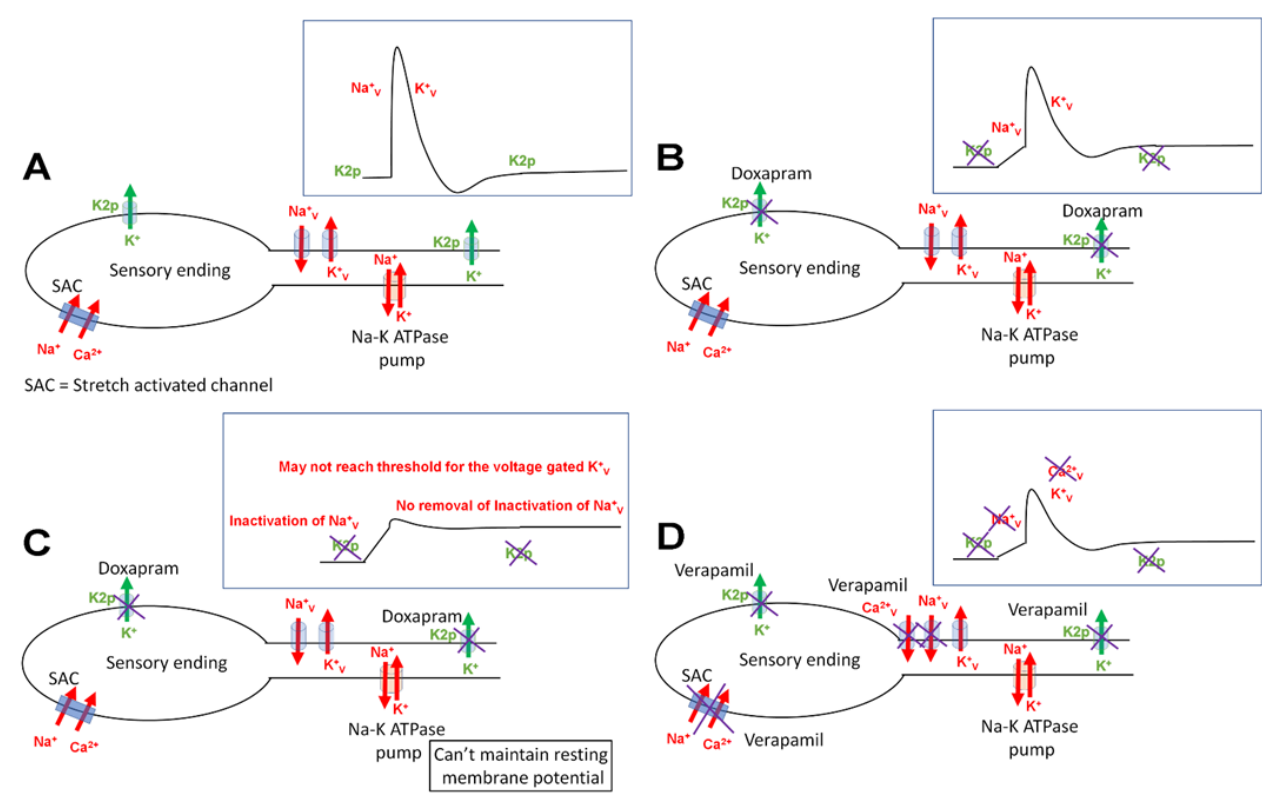
Figure 12. A representative model to explain the observed phenomenon with exposure to doxapram in relation to the neural activity in sensory neurons of the PD organ in a crab preparation. ( A ) A representative sensory neuron which is activated by opening stretch activated ion channels (SACs). The depolarization from activating SACs may reach the threshold to open voltage-gated Na + channels (Na v+ ) and, subsequently, voltage-gated K + channels (K v+ ) to allow action potentials to travel along the nerve (see inset in top right corner). The K2p channels help to maintain the resting membrane potential along with the Na + -K + ATP dependent pump. ( B ) In the presence of doxapram, the K2p channels are blocked. ( C ) The effect of blocking the K2p channels depolarizes the neurons. A low level may bring the membrane closer to threshold to activate the Na v+ channels and produce more action potentials for the same stimulus. However, if the neuron depolarizes and cannot repolarize, the inactivation of the Na v+ channels would result in prolonged absolute refractory periods while exposed to doxapram, not allowing the neuron to be excitable. ( D ) The potential effects of verapamil are illustrated. The SACs are likely blocked rapidly upon exposure to low and high concentrations. On the axon, the voltage gated Ca 2+ channels (Ca v2+ ) as well as the Na v+ may be a target given the compound action potential is slowly depressed over time, independent of the actions on the SACs in the sensory endings.